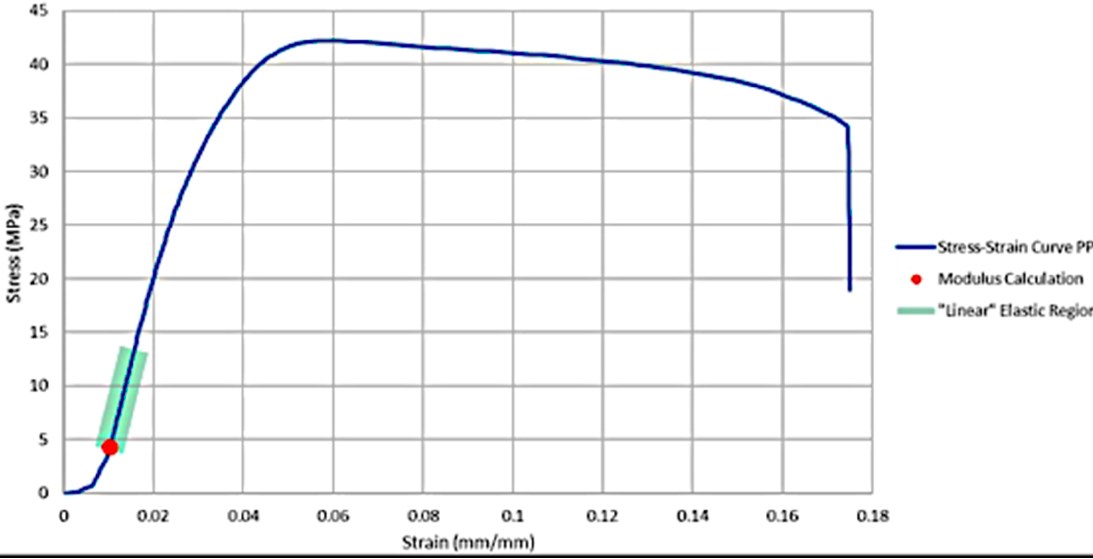
Figure 3. The stress–strain curve for a neat PP sample subjected to tensile testing.